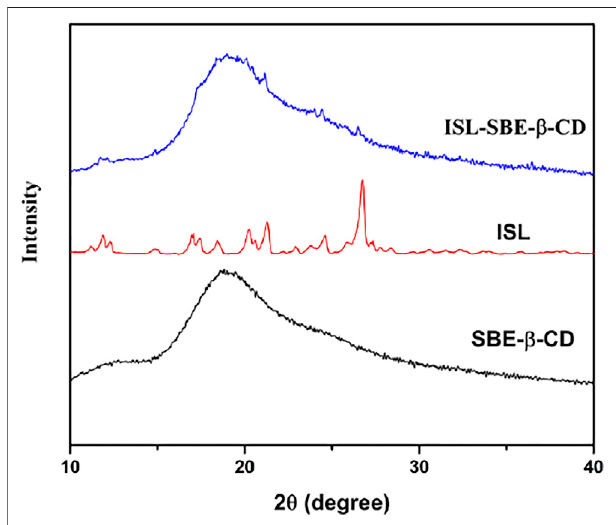
FIGURE 2 | XRD patterns of ISL, SBE- β -CD, and ISL-SBE- β